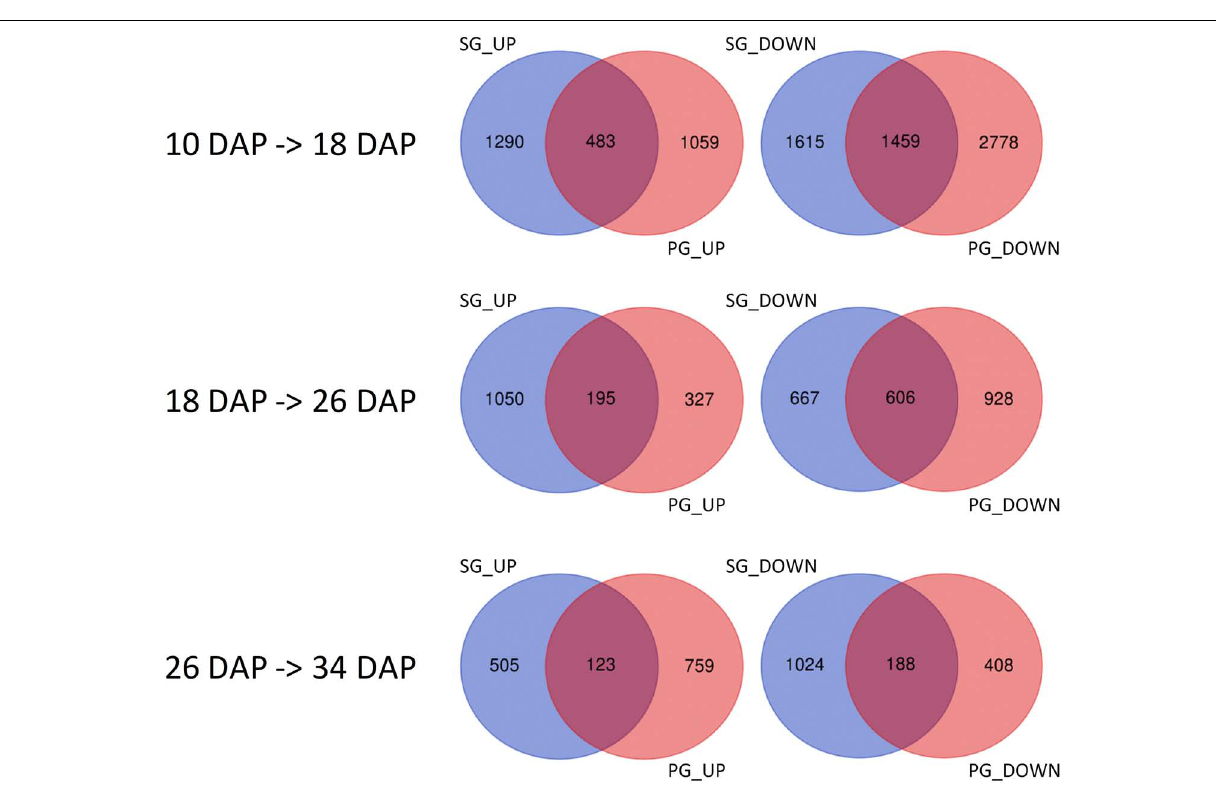
FIGURE 4 | Identification of the differentially expressed genes in self-grafted (SG) watermelon plant and pumpkin-grafted (PG) watermelon plant. DAP, days after pollination; SG_UP, up-expressed genes in SG plant; SG_DN, down-expressed genes in SG plant; PG_UP, up-expressed genes in PG plant; PG_DN, down-expressed genes in PG